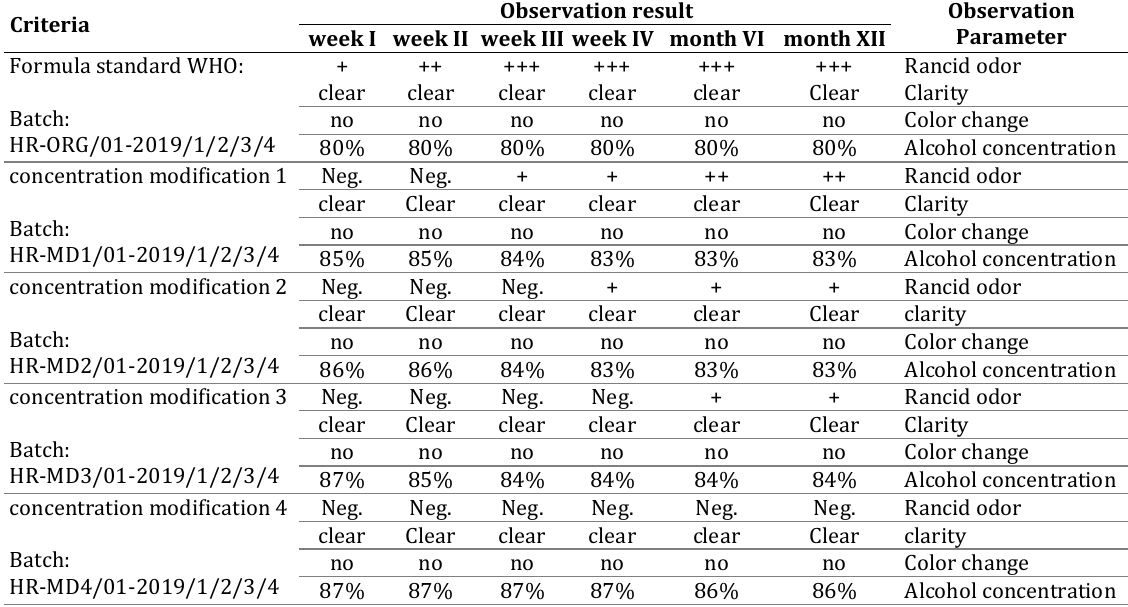
Observation result